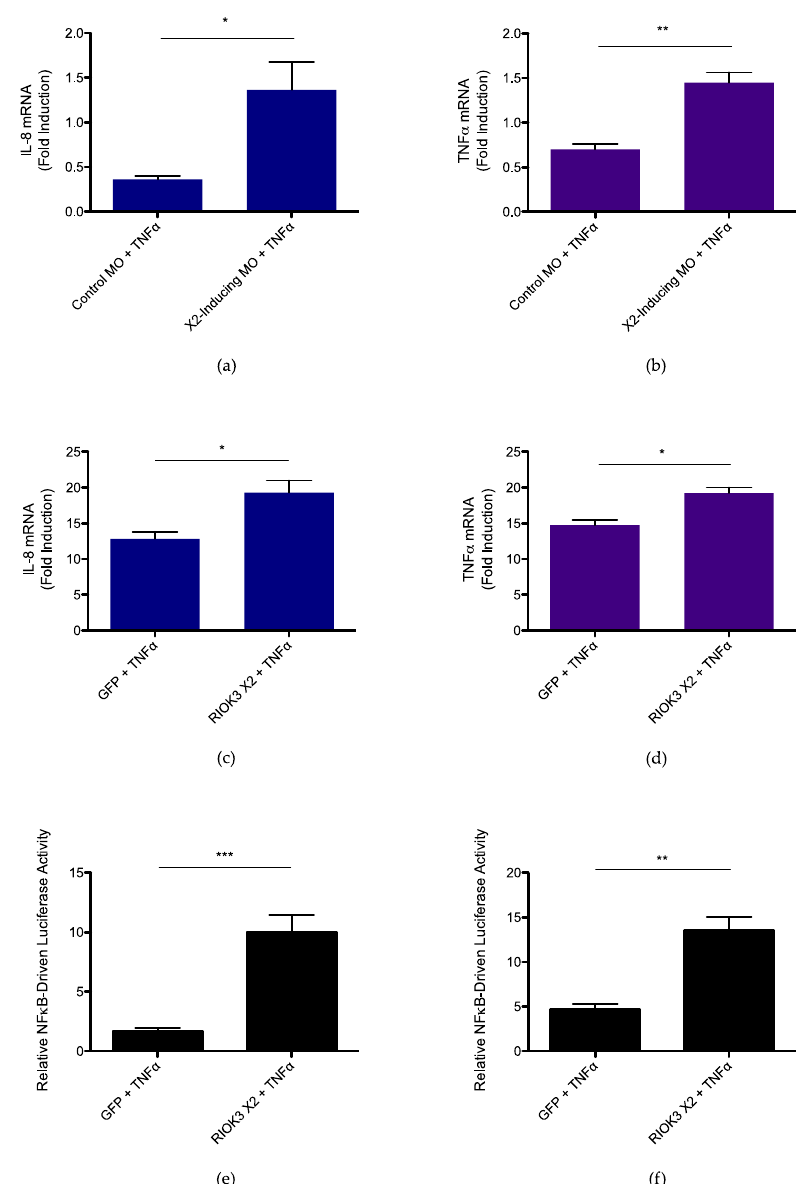
Figure 5. RIOK3 X2 expression triggers inflammatory pathway activation. ( a ) IL-8 mRNA expression in X2-inducing MO- vs. standard control MO-treated WT HEK 293 cells ( b ) TNF α mRNA expression in X2-inducing MO- vs. standard control MO-treated WT HEK 293 cells ( c ) IL-8 mRNA expression in GFP- vs. RIOK3 X2-transfected WT HEK 293 cells ( d ) TNF α mRNA expression in GFP- vs. RIOK3 X2-transfected WT HEK 293 cells ( e ) Luciferase assay measuring NF κ B promoter activity in GFP- vs. RIOK3 X2-transfected WT HEK 293 cells ( f ) Luciferase assay measuring NF κ B promoter activity in GFP- vs. RIOK3 X2-transfected RIOK3 KO HEK 293 cells. In plots ( a , b ), fold induction is relative to values of cells transfected with standard control MO and that were not treated with TNF α . Cells were grown in 12-well plates, seeded at a density ~0.2 × 10 6 cells/well, and treated with 80 ng/mL TNF α for 4 h. In ( c , d ), fold induction is relative to values of cells transfected with GFP and that were not treated with TNF α . In ( c – f ), cells were grown in 12-well plates, seeded at a density ~0.1 × 10 6 cells/well, and treated with 20 ng/mL TNF α . In ( c – e ), cells were treated with TNF α for 4 h, and in ( f ), cells were treated with TNF α for 24 h. Plots in ( a – f ) present the data as the mean value of 3 biological replicates +/ − SEM. Student’s t -test: * p < 0.05, ** p < 0.01, *** p <